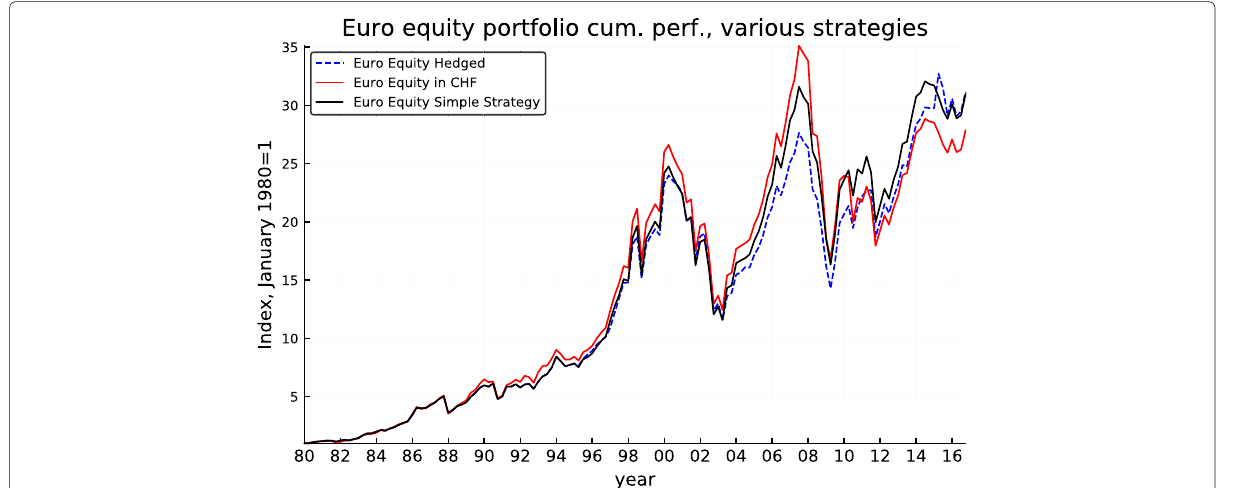
Fig. 6 Euro equity cumulative performance: unhedged, hedged, and simple